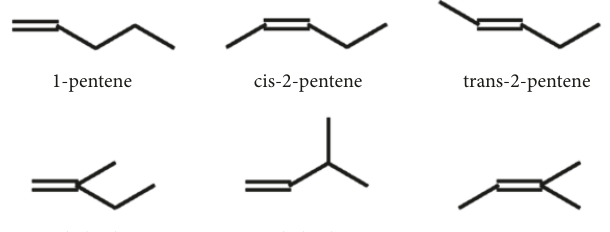
the pentane isomers at equivalence ratios of 0.5, 1.0, and